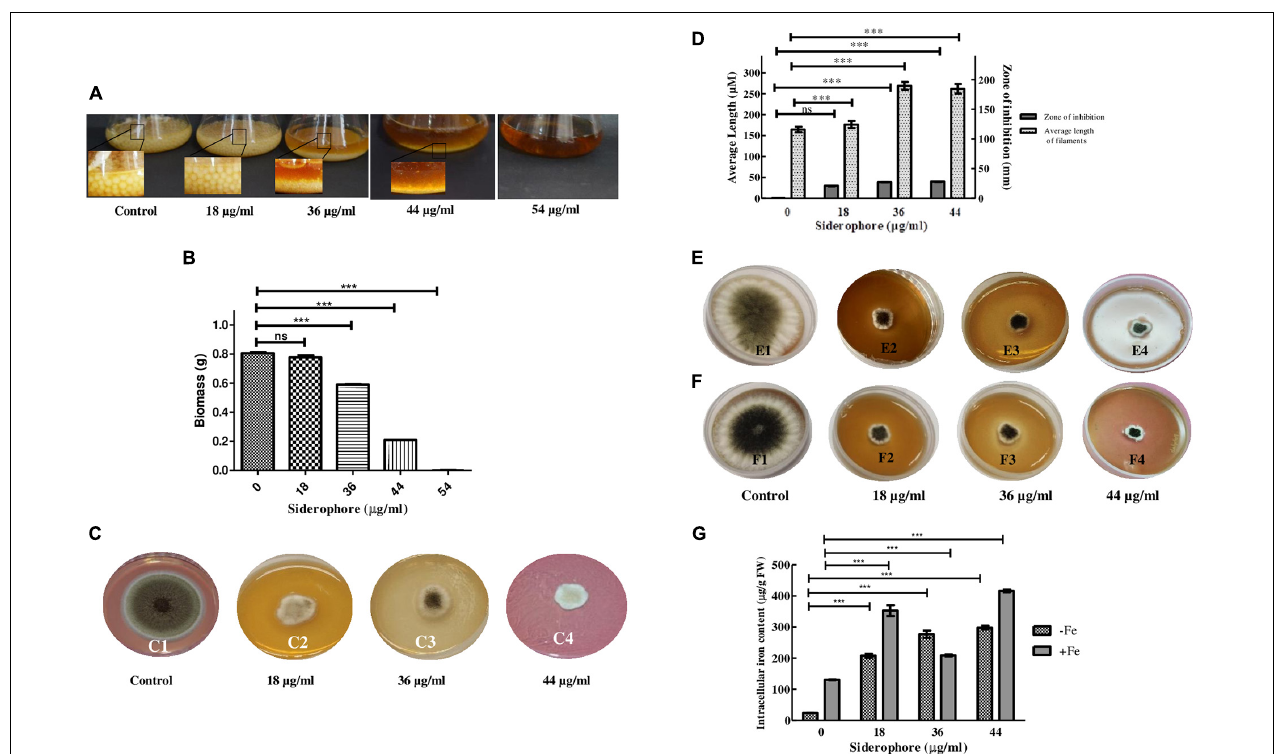
FIGURE 2 | Effect of varying siderophore concentrations after 48 h on (A) colony of A. nidulans in YEPD culture (Inset—colony size). (B) Biomass of A. nidulans in YEPD culture. (C) Growth of A. nidulans on YEPD solid media under varying concentrations of siderophore: 1—no siderophore, 2—18 µ g/ml, 3—36 µ g/ml, 4—44 µ g/ml. (D) Average filament length and zone of inhibition at different siderophore concentrations without iron supplement. (E) Growth of A. nidulans on YEPD media with 2 mM FeCl 3 supplement under varying concentrations of siderophore: 1—no siderophore, 2—18 µ g/ml, 3—36 µ g/ml, 4—44 µ g/ml. (F) Growth of A. nidulans on YEPD media with 4 mM FeCl 3 supplement under varying concentrations of siderophore: 1—no siderophore, 2—18 µ g/ml, 3—36 µ g/ml, 4—44 µ g/ml. (G) Intracellular iron content of A. nidulans under iron deplete and 4 mM iron supplement at different siderophore treatments (ns—non-significant, *** p ≤ 0.001—highly